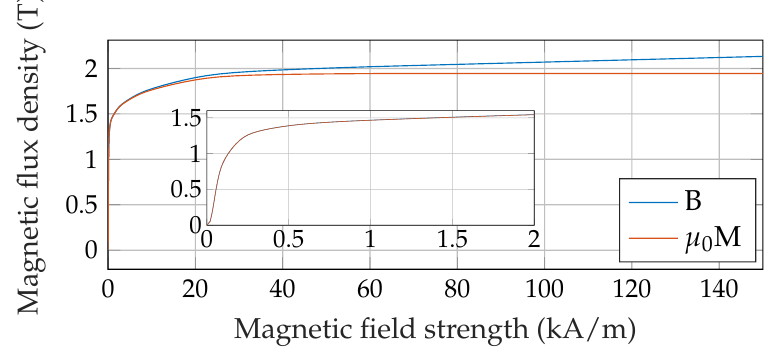
Figure 3. B-H curve for Silicon Steel NGO 50PN270 used in the translator and stator iron. The zoomed-in version shows the hysteresis-free consideration in this study.